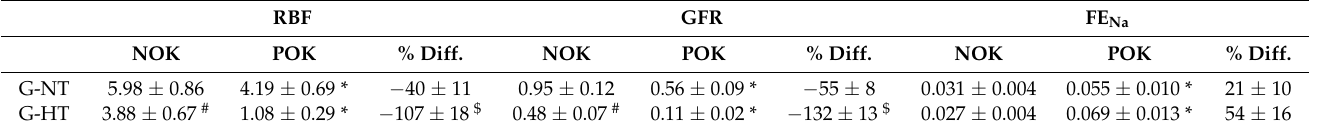
Table 1. The glomerular filtration rate (GFR), renal blood flow (RBF), and the fractional excretion of sodium FENa in the left post-obstructed (POK) and right non-obstructed (NOK) kidneys in both the spontaneously hypertensive (G-HT) and the control normotensive (G-NT) rats. RBF GFR FE Na NOK POK % Diff. NOK POK % Diff. NOK POK % Diff. G-NT 5.98 ± 0.86 4.19 ± 0.69 * − 40 ± 11 0.95 ± 0.12 0.56 ± 0.09 * − 55 ± 8 0.031 ± 0.004 0.055 ± 0.010 * 21 ± 10 G-HT 3.88 ± 0.67 # 1.08 ± 0.29 * − 107 ± 18 $ 0.48 ± 0.07 # 0.11 ± 0.02 * − 132 ± 13 $ 0.027 ± 0.004 0.069 ± 0.013 * 54 ± 16 % Diff: the percentage difference between the POK and NOK in each group; * indicates statistical significance between the POK and NOK in each group; $ indicates statistical significance in the % difference between the G-HT and G-NT rats; # indicates statistical significance between the NOK in the G-HT and G-NT